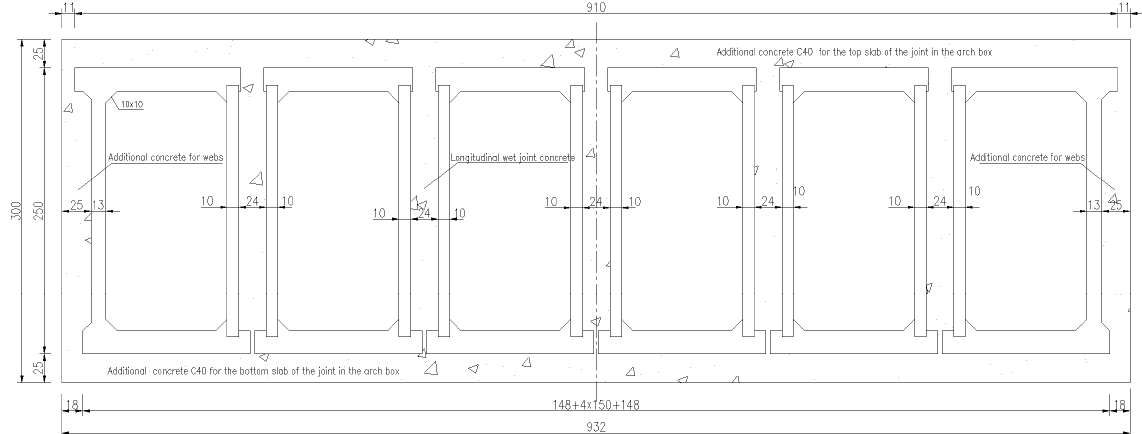
Figure 8. Schematic diagram of arch ring section.